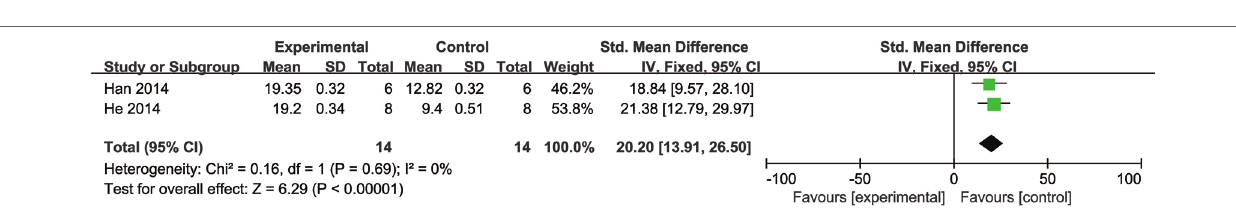
FIGURe 9 | The forest plot: effects of notoginsenoside R1 for increasing ATP compared with the control group (n = 14 per group).